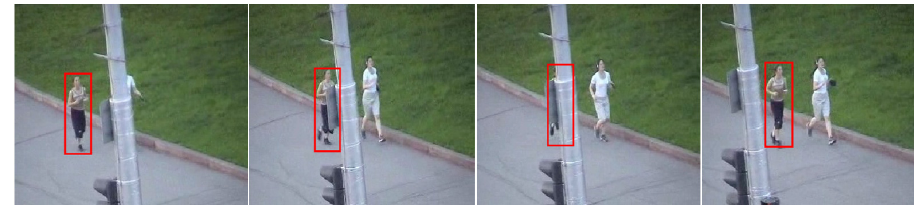
Figure 21. Tracking object for occlusion case.